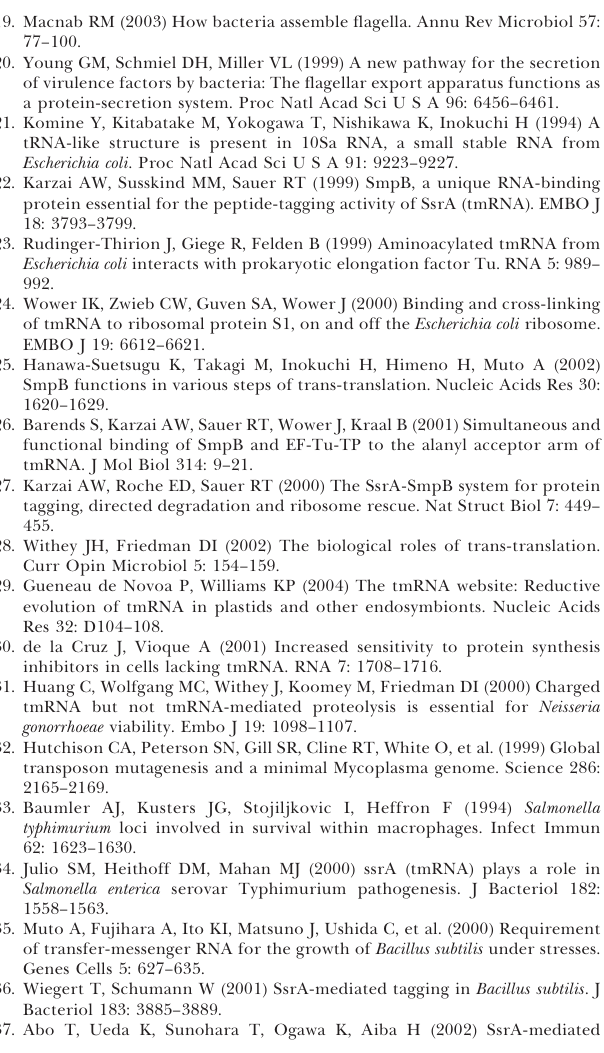
Figure S1. The D BA Mutant of Y. pseudotuberculosis Shows High Sensitivity to Translation-Specific Antibiotics Equal number of bacterial cells from saturated cultures of wild-type and D BA strains were serially diluted and spotted onto plates containing various concentrations of the indicated antibiotic. Plates were incubated at 26 8 C for 3 d.